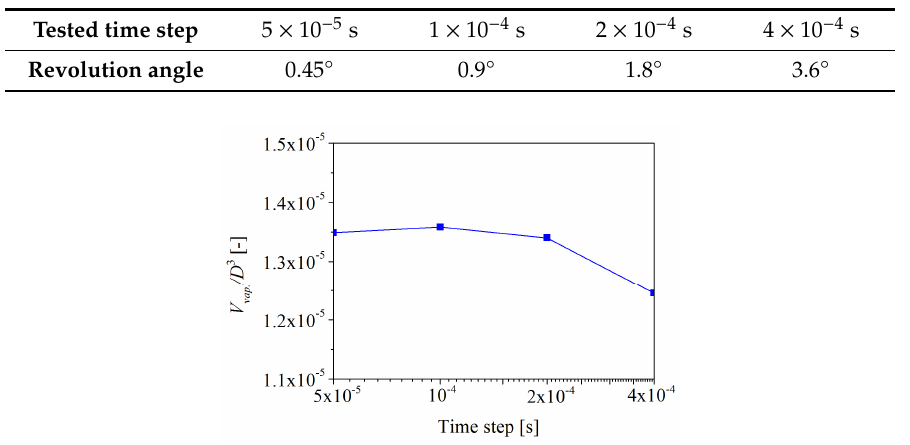
Table 4. Corresponding revolution angle.